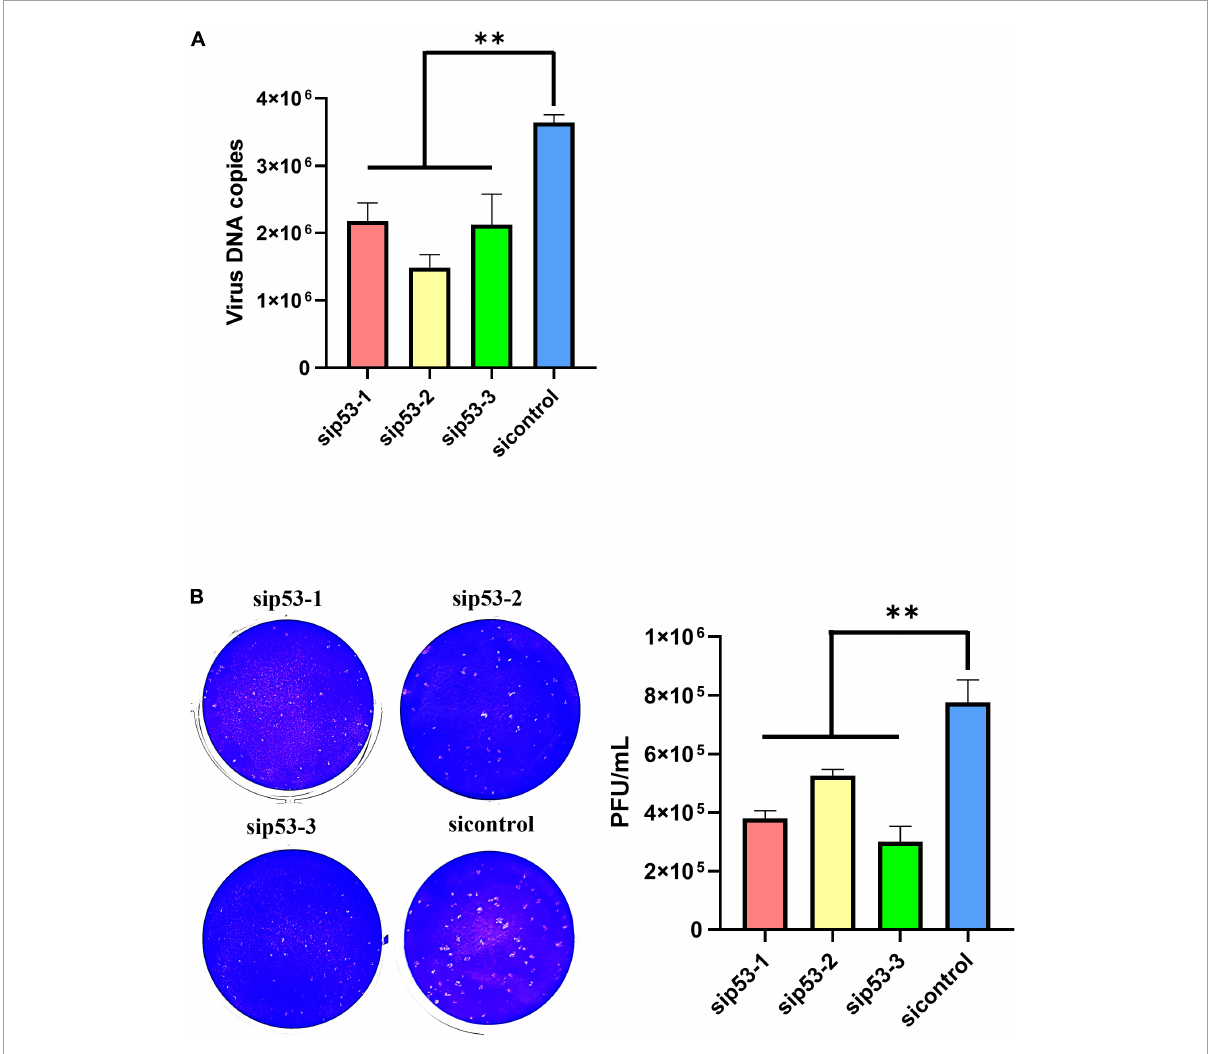
FIGURE2 P53 is a host determinant of ILTV replication in LMH cells. (A) At 12 hpi, viral genome copy numbers were determined by ILTV-specific RT-qPCR assays. (B) The number of infectious virions was quantified by plaque assays at 3 dpi. The results are presented as the mean ± SD, n = 3. ** p < 0.01 indicates the levels of